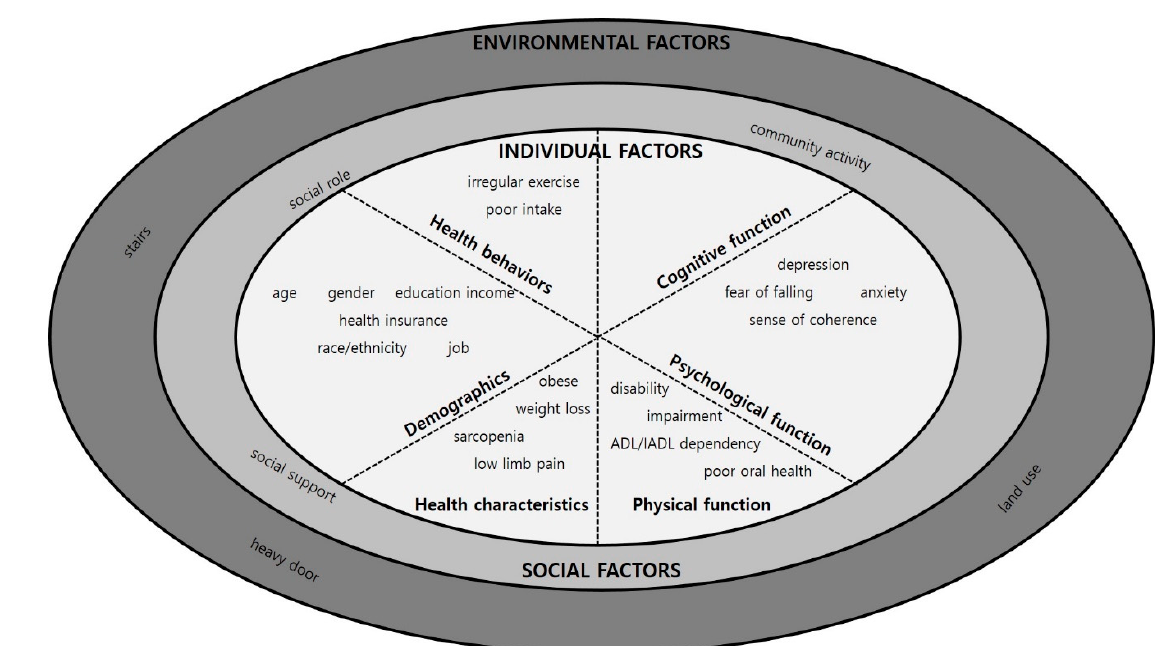
Figure 2. Significant determinants of HB. Table 4. Determinants of HB state based on individual, social, and environmental factors.